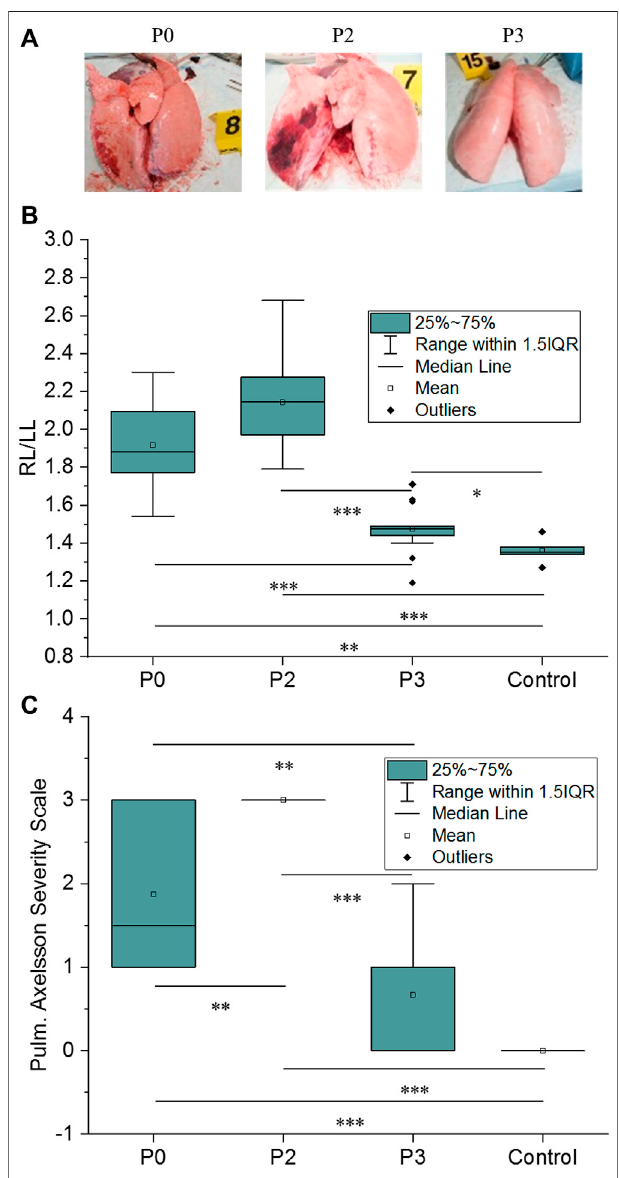
FIGURE 4 | (A) Example of lung injuries observed on animals for P0, P2, and P3 groups; (B) Right-to-Left lung weight ratio (RL/LL) and (C) Pulmonary Axelsson Severity Scale as a function of the protection level. 25 ∼ 75% represents the fi rst and the third quartile. IQR is the interquartile range. Median and mean values of the dataset are indicated. *: p < 0.05, **: p < 0.01, and ***: p < 0.001 (Mann-Whitney test).